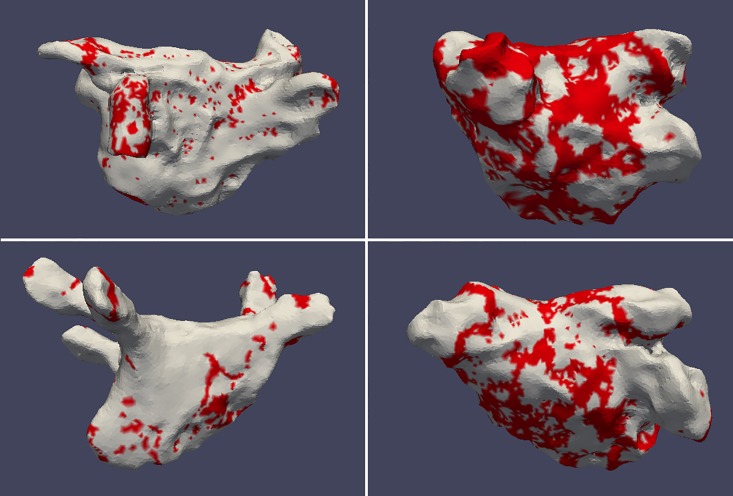
Representative LA voltage maps of 4 separate patients.Top row—patients mapped in AF. Bottom row—patients mapped in SR. Red areas represent <0.5mV. Left column—<30% low voltage, right column >30% low voltage.